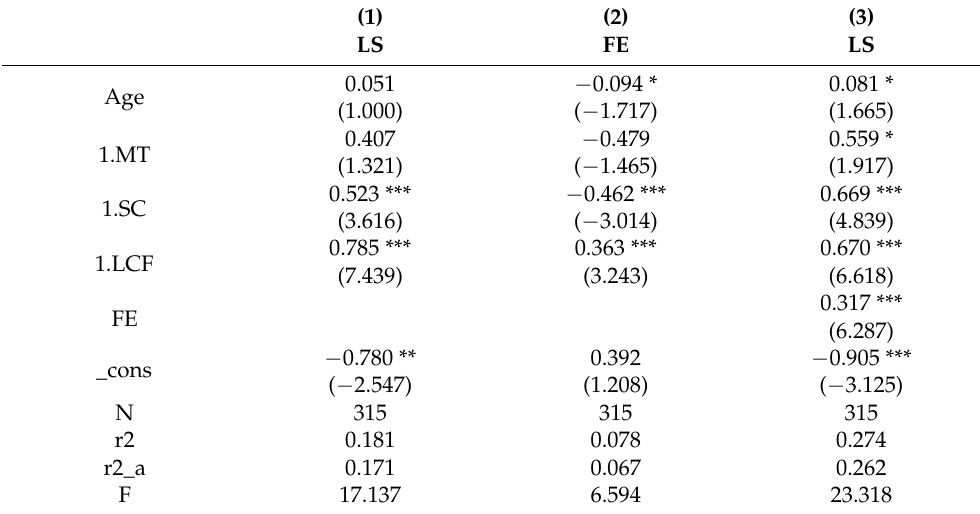
Table 8. The Mediating Effect of Farming Expectations on the Impact of Land Cultivation Facilities on Life